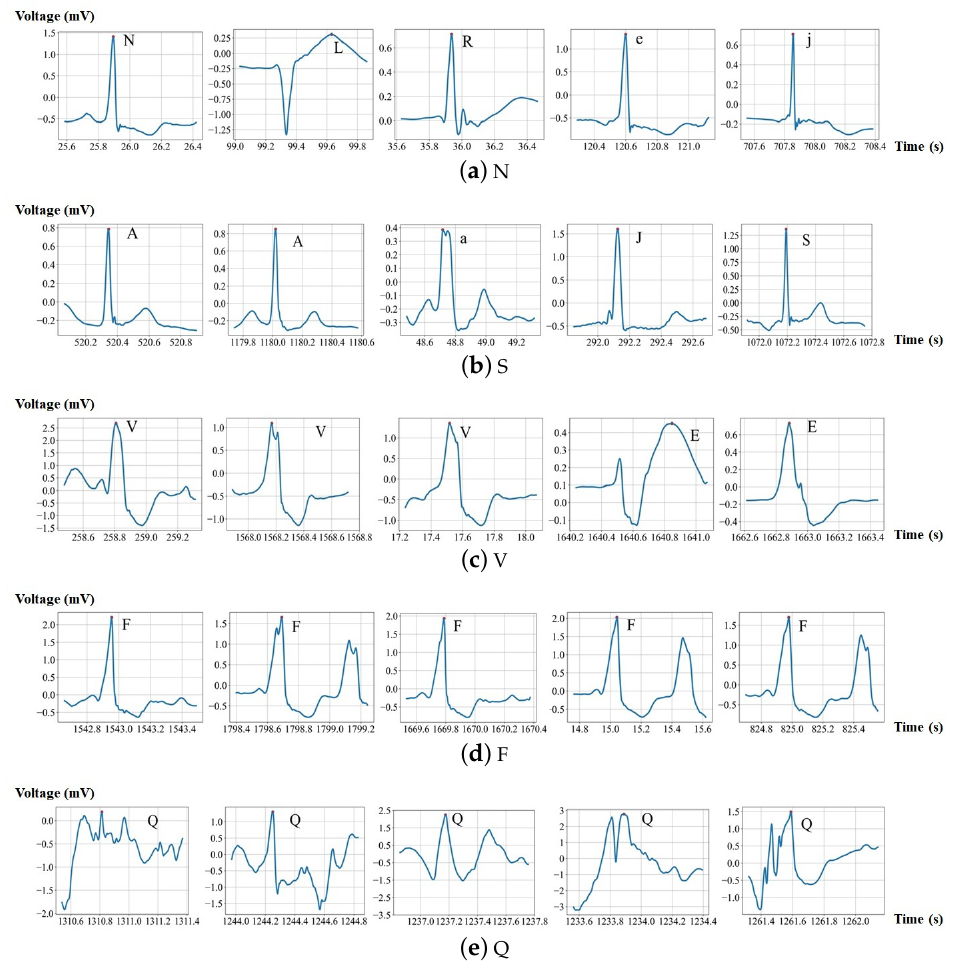
Figure 2. Different classes of heartbeats after segmentation. ( a ) Samples in class N. ( b ) Samples in class S. ( c ) Samples in class V. ( d ) Samples in class F. ( e ) Samples in class